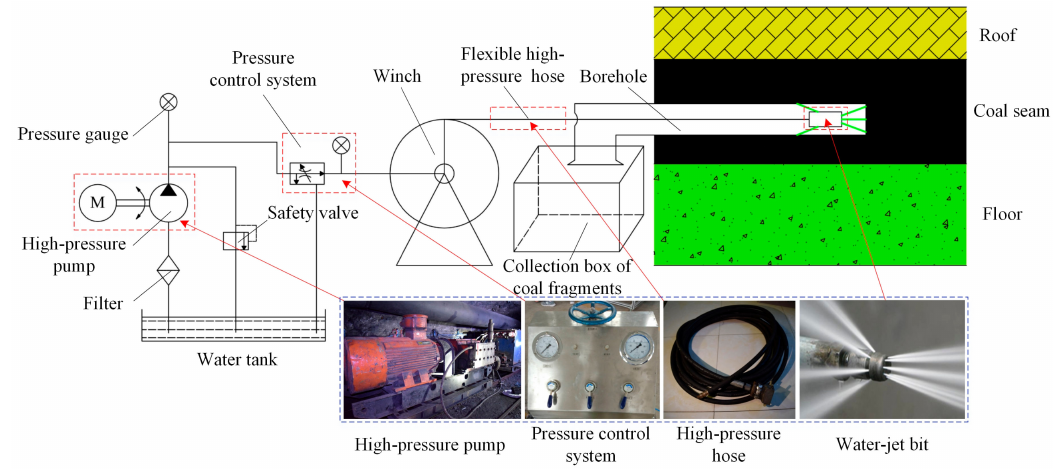
Figure 1. Schematic of WJD system in underground coal